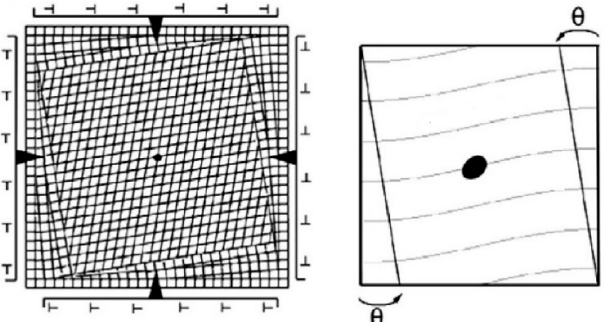
Figure 2. Back-stress-induced rotation field explained with a simple square-rhombus transformation. If the Geometrically Necessary Dislocations (GND) resulting from the accommodation of the lattice distortion are blocked at the grain boundaries or other interfaces, they accumulate and generate a back-stress field that induces the continuous rotation of the martensite. The rotation gradients are the origin of the continuums of orientation relationships (ORs) observed in the martensite of low-carbon steels. Adapted from [45].